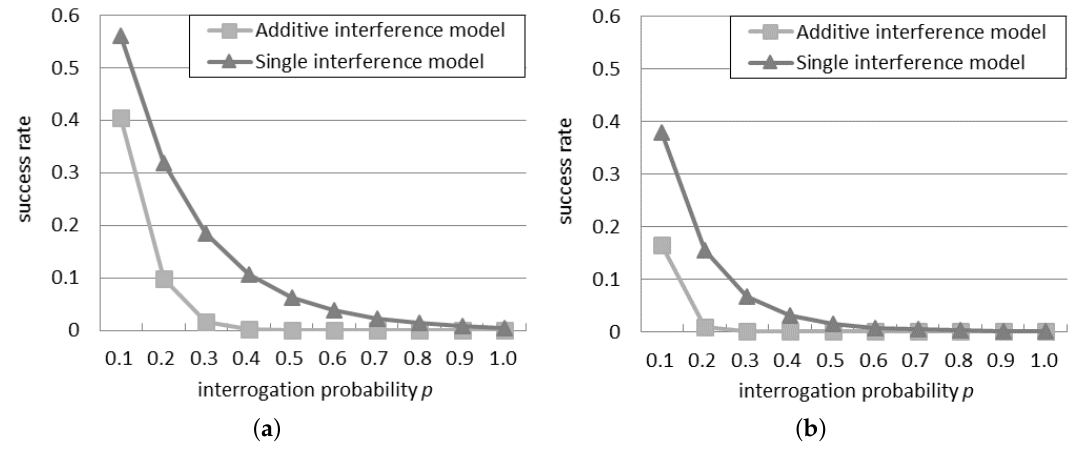
Figure 1. Success rate in the probabilistic interrogation scenario: ( a ) 30 readers; ( b ) 50